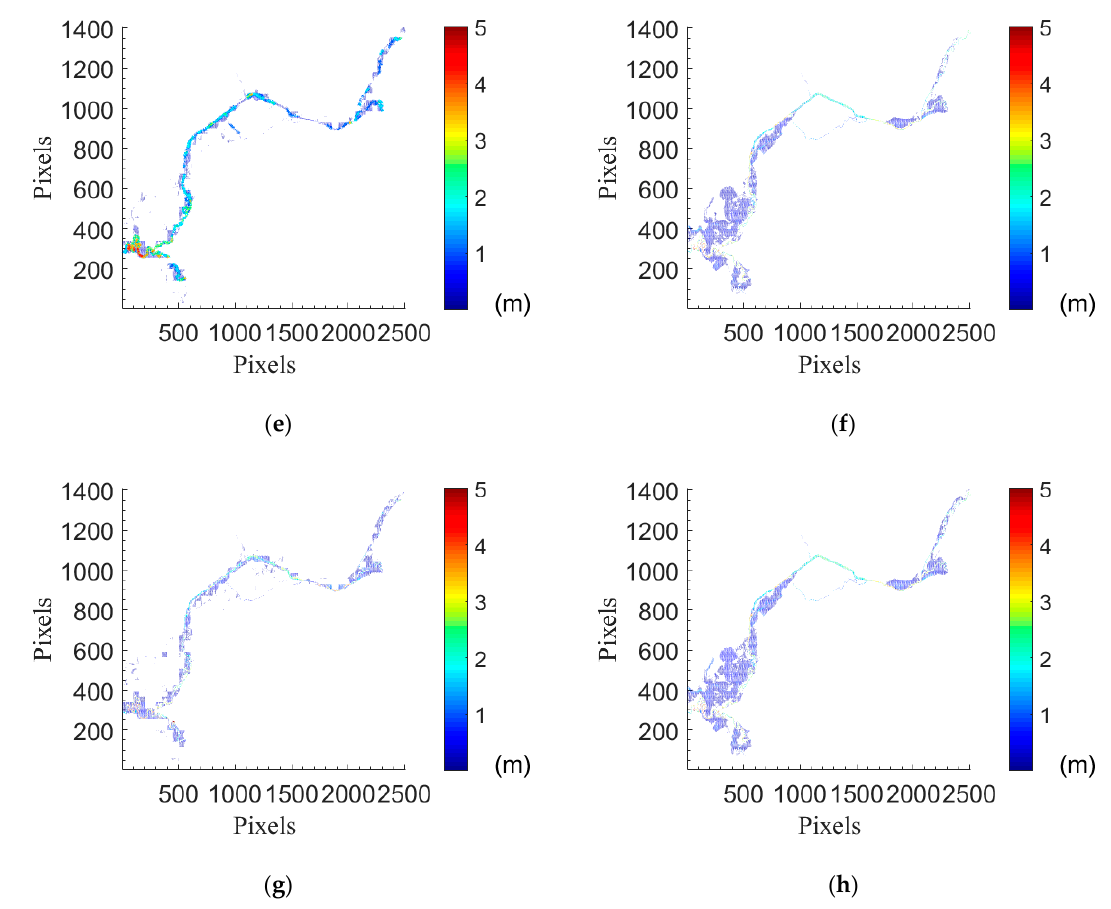
Figure 10. Inundation maps from the prediction of water depths of the first intervals in flood event 2005. ( a ) ANN inundation map 3 h; ( b ) hydrodynamic inundation map 3 h; ( c ) ANN inundation map 6 h; ( d ) hydrodynamic inundation map 6 h; ( e ) ANN inundation map 9 h; ( f ) hydrodynamic inundation map 9 h; ( g ) ANN inundation map 12 h; ( h ) hydrodynamic inundation map 12 h. Table 4. Numbers of wet grids and accurate grid percentages for the flood event in 2005. A wet grid is with the water level over 0.1 m; any water depth below this cutoff value is eliminated. Table shows grid numbers with larger RMSE and their percentages to the total wet grids.